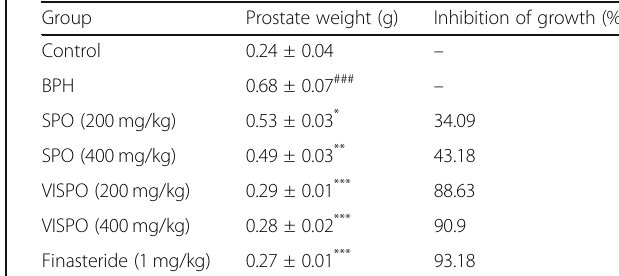
Fig. 2 Effect of SPO and VISPO on prostate weight and prostate to body weight (PW/BW) ratio. The data were analyzed by one way ANOVA followed by Dunnet ’ s t-test. ## p < 0.01 vs. control group. * p < 0.05, *** p < 0.001 vs. the BPH group